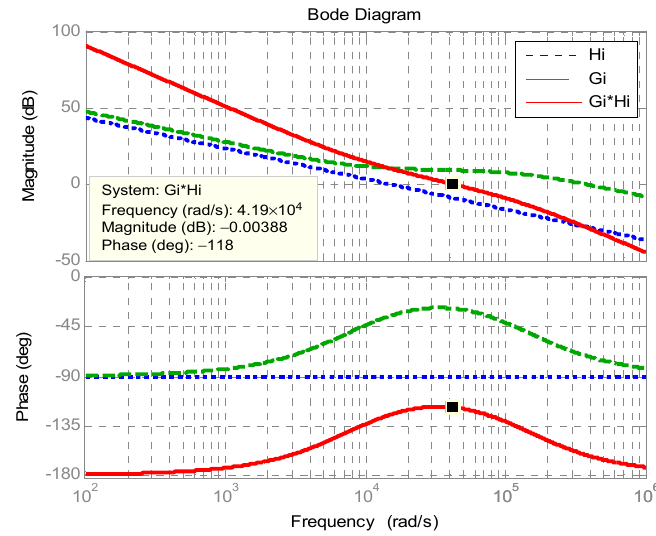
Figure 6. Bode plot of inner inductor current control loop.